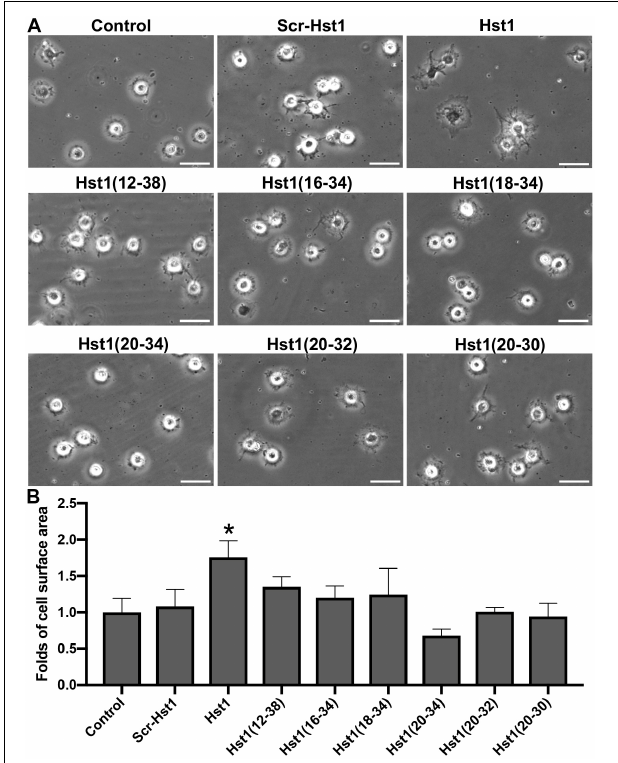
FIGURE 2 | The effect of truncated Hst1 variants on the spreading of osteogenic cells. (A) Light micrographs depicting the spreading of osteogenic cells in the presence or absence of scrambled Hst1 and 6 truncated variants of Hst1 on glass surfaces. Bar = 50 µ m. (B) Folds of cell spreading surface area in the presence or absence of scrambled Hst1 and 6 truncated variants of Hst1 on glass. Data are shown as mean ± SD ( n = 6). * p < 0.05.